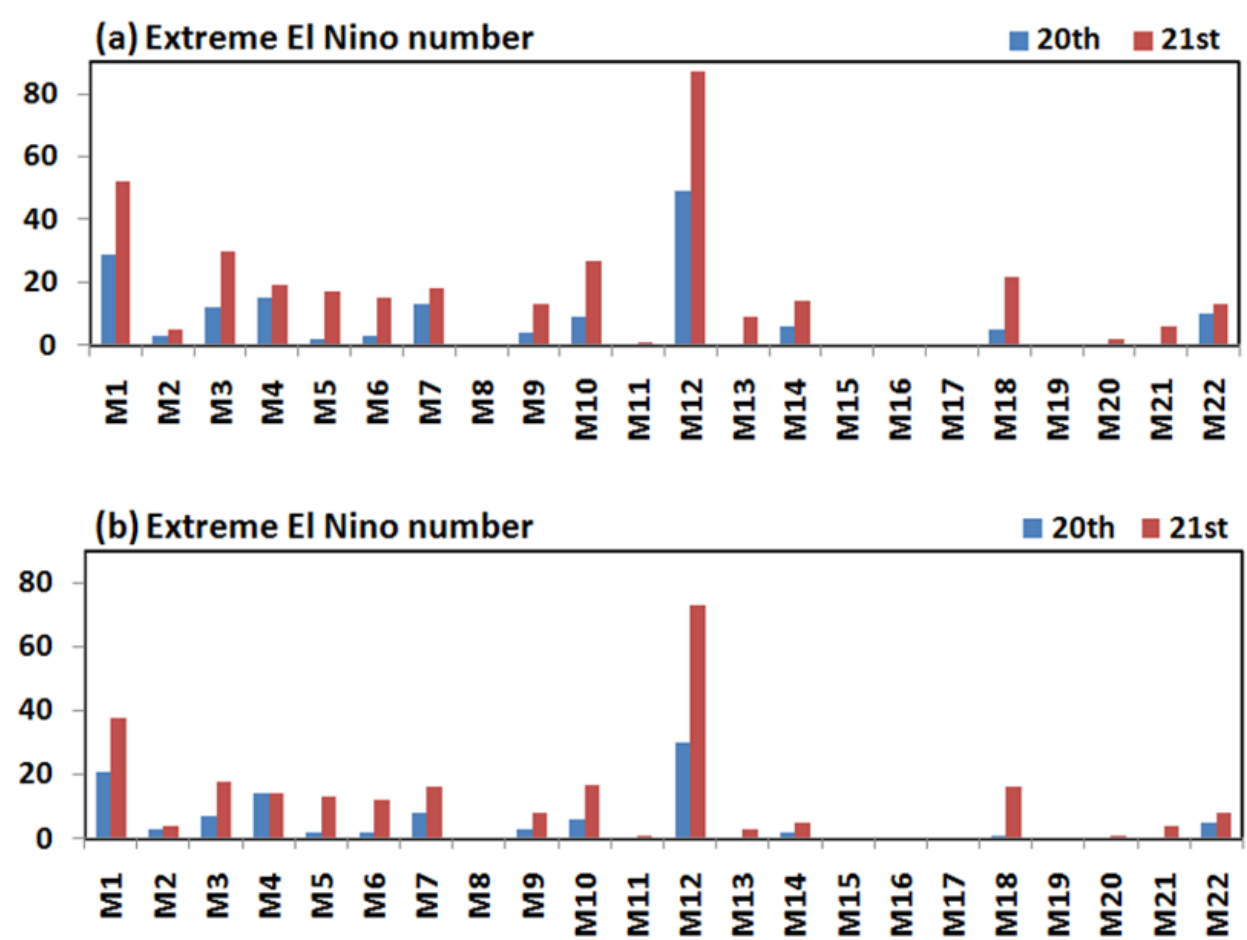
Figure 4. The number of extreme El Niño occurrences for the 21st versus the 20th century in 22 CMIP5 models. An extreme El Niño event in ( a ) was identified when the Niño3 DJF precipitation was over 5 mm/day. ( b ) Same as ( a ), but an extreme El Niño was identified when the Niño3 DJF precipitation was over 6 mm/day.